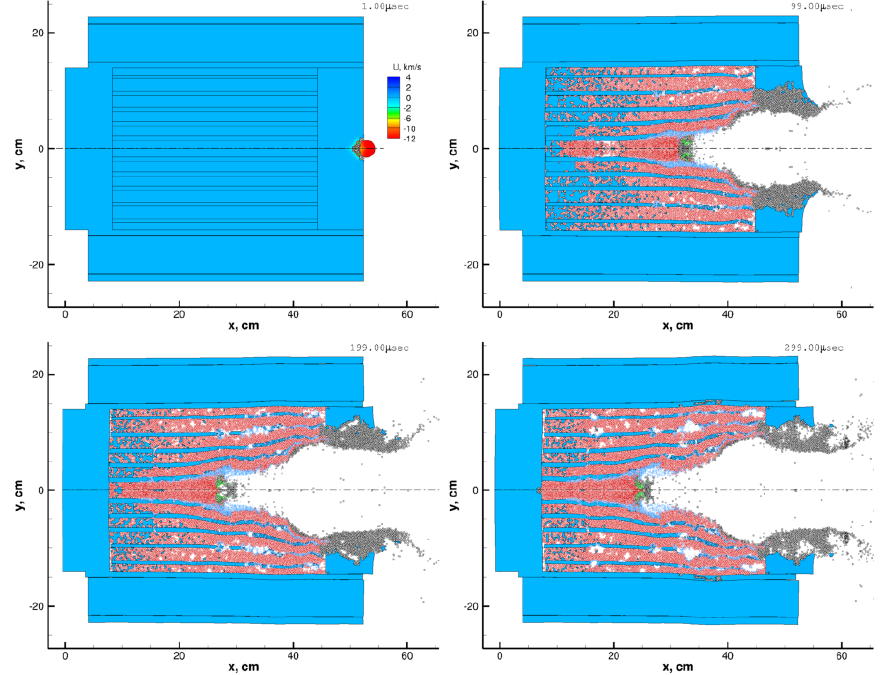
Figure 13: Photographic records of the impact of space debris with a reactor (axial